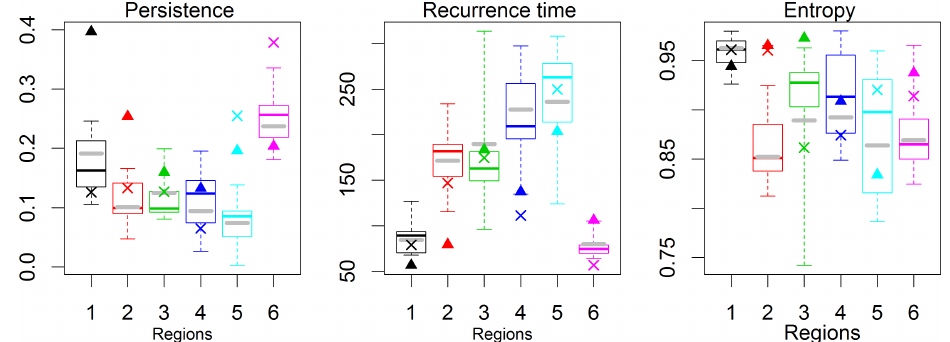
Figure 4. Descriptors for cold and wet extremes in winter (DJF) (Ta < 10th percentile and Pa > 75th percentile) in the reference period 1971– 2000 for the six investigation areas. Box plots of the CCLM ensemble: box is the ensemble median and interquartile range and whiskers are ensemble minimum/maximum; gray bars: ensemble mean; triangles: reanalysis-driven CCLM runs; crosses: E-OBS observations. The coloring corresponds to the regions in Fig. 1.